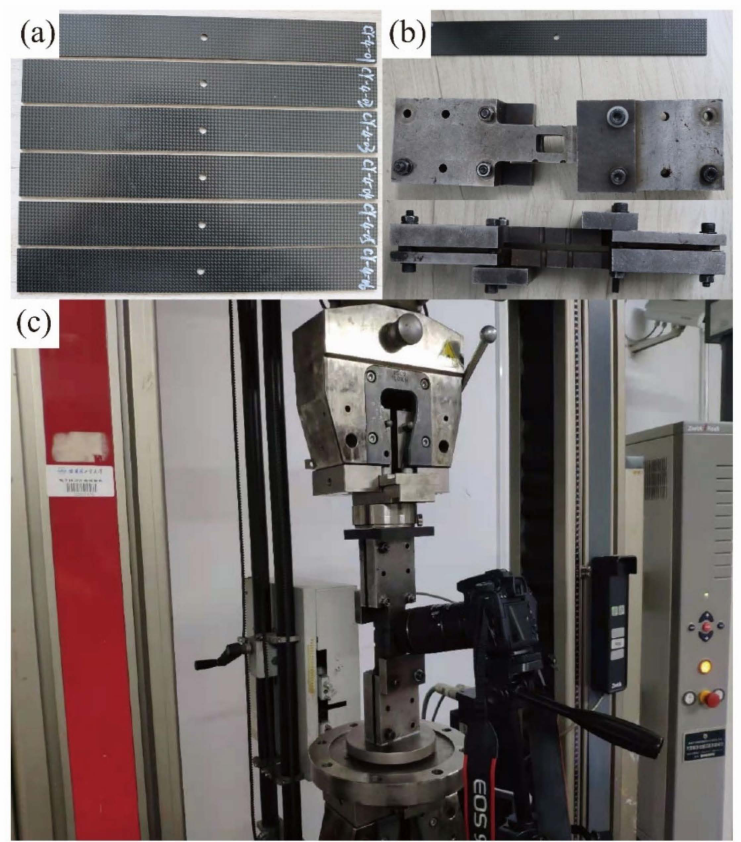
Figure 13. Specimens of the T300/Cycom970 fabric open-hole laminates and the loading system of the compression experiments: ( a ) the specimens of the open-hole laminates; ( b ) the fixture of the open-hole compression experiments; ( c ) the testing